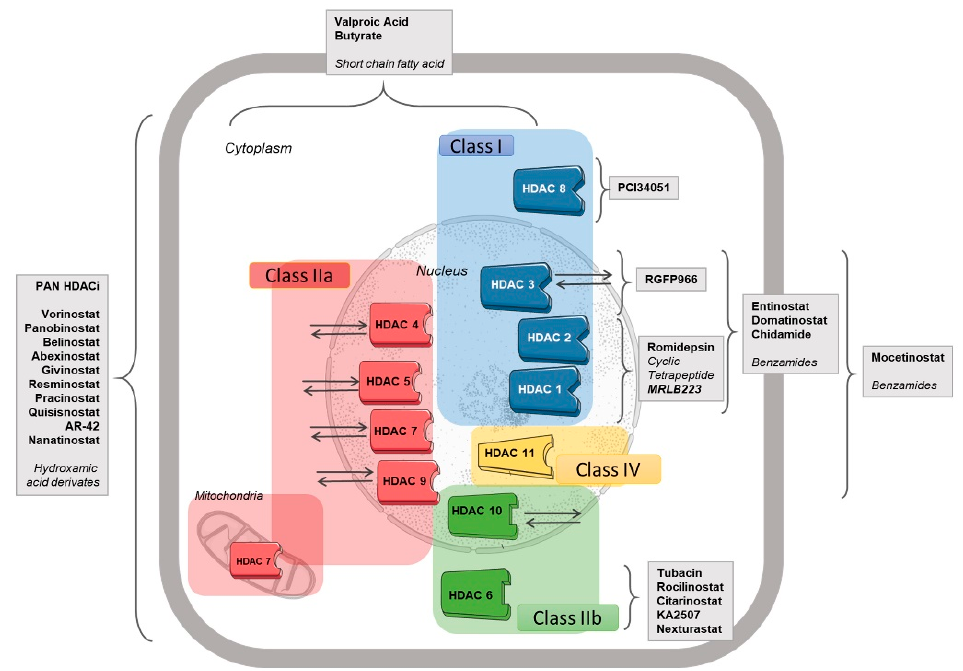
Figure 1. Classification of HDAC, their cellular localization and their inhibitors (HDACis). According to their structure and function, HDAC proteins are grouped into four classes. Class III deacetylases, sirtuins proteins, are not depicted here.